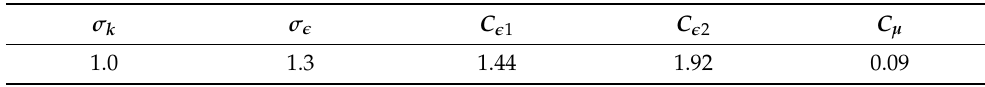
Table 1. Closure coefficients for the baseline turbulence